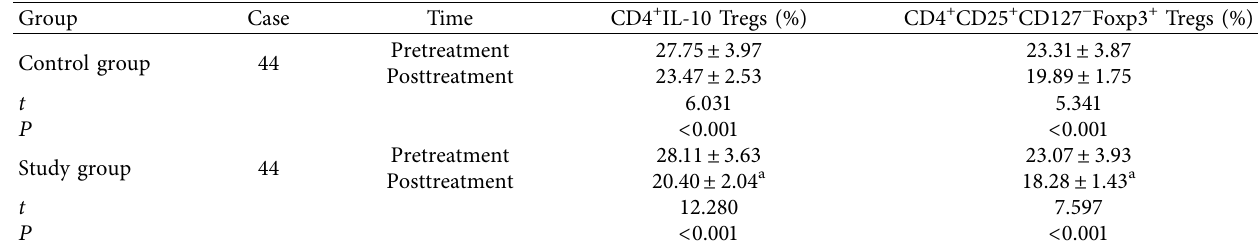
Table 3: The proportions of CD4 + IL-10 Tregs and CD4 + CD25 + CD127 − Foxp3 + Tregs in peripheral blood in AML patients following intravenous administration of cytarabine supplemented with either idarubicin or daunorubicin. Group